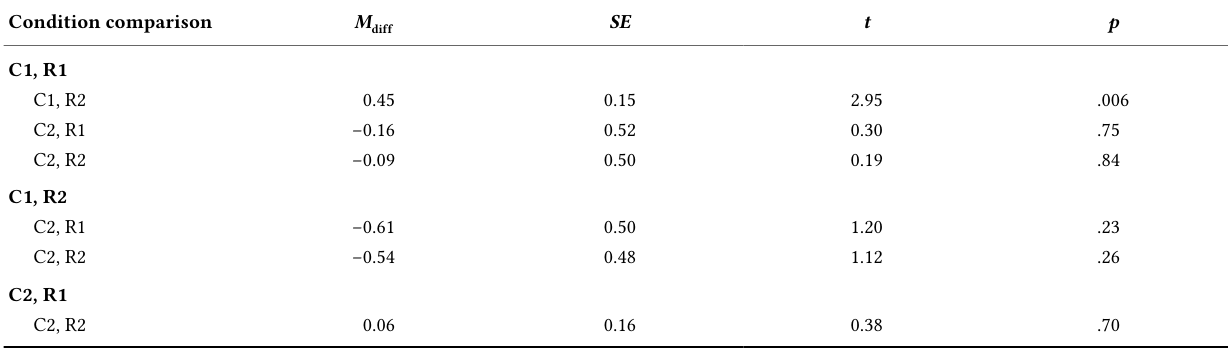
Table 14 indicates the results for the specific research question for Experiment 3.